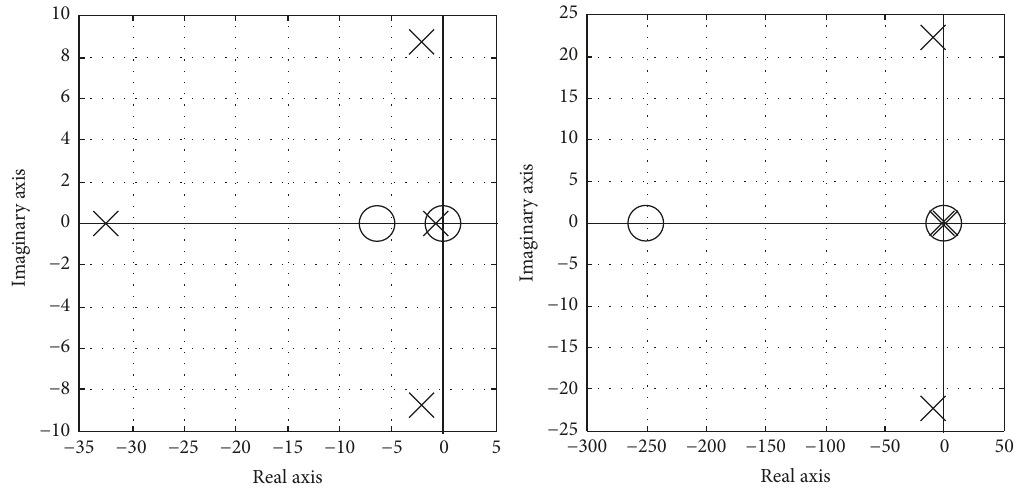
Figure 10: Conventional robust H ∞ control for vehicle body side-rolling acceleration. (a) Without perturbation. (b) With